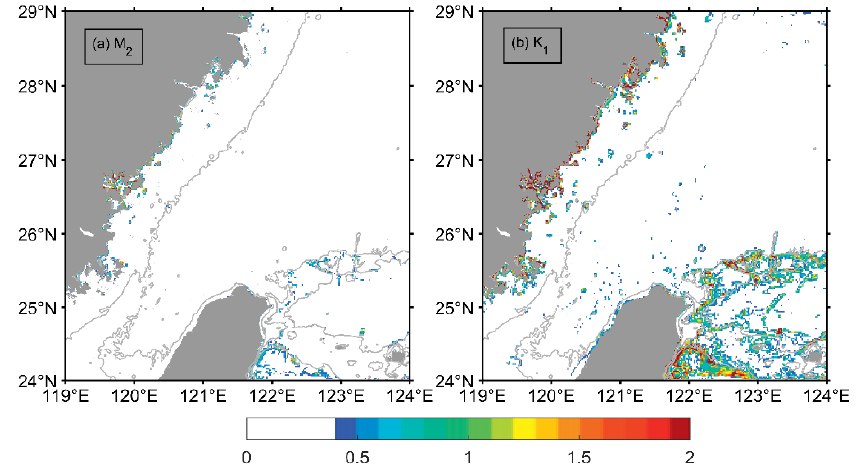
Figure 13. Bathymetry criticality (α) for ( a ) M 2 and ( b ) K 1 tidal constituents.